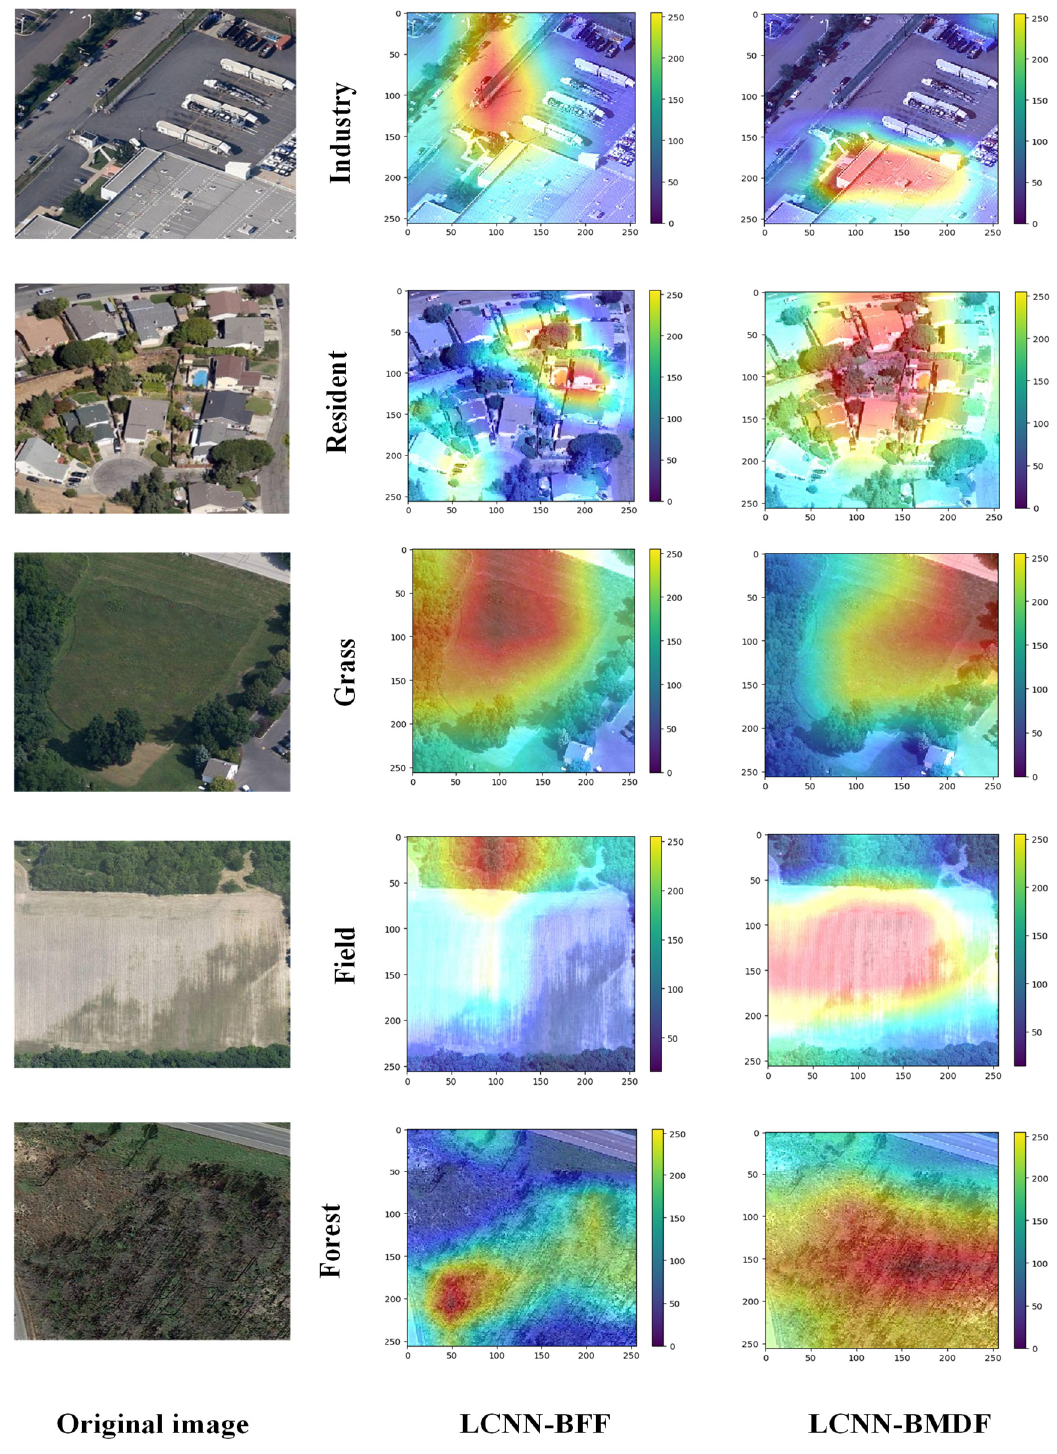
Figure 7. Thermal diagram on RSSCN dataset. Next, we visualize the classification results on UC (8/2) and RSSCN (5/5) datasets using t-distribution random neighbor embedding (T-SNE). T-SNE maps high-latitude fea- tures to two-dimensional or three-dimensional space for visualization, which can evaluate the classification effect of the model very well. The result of the T-SNE visualization is shown in Figure